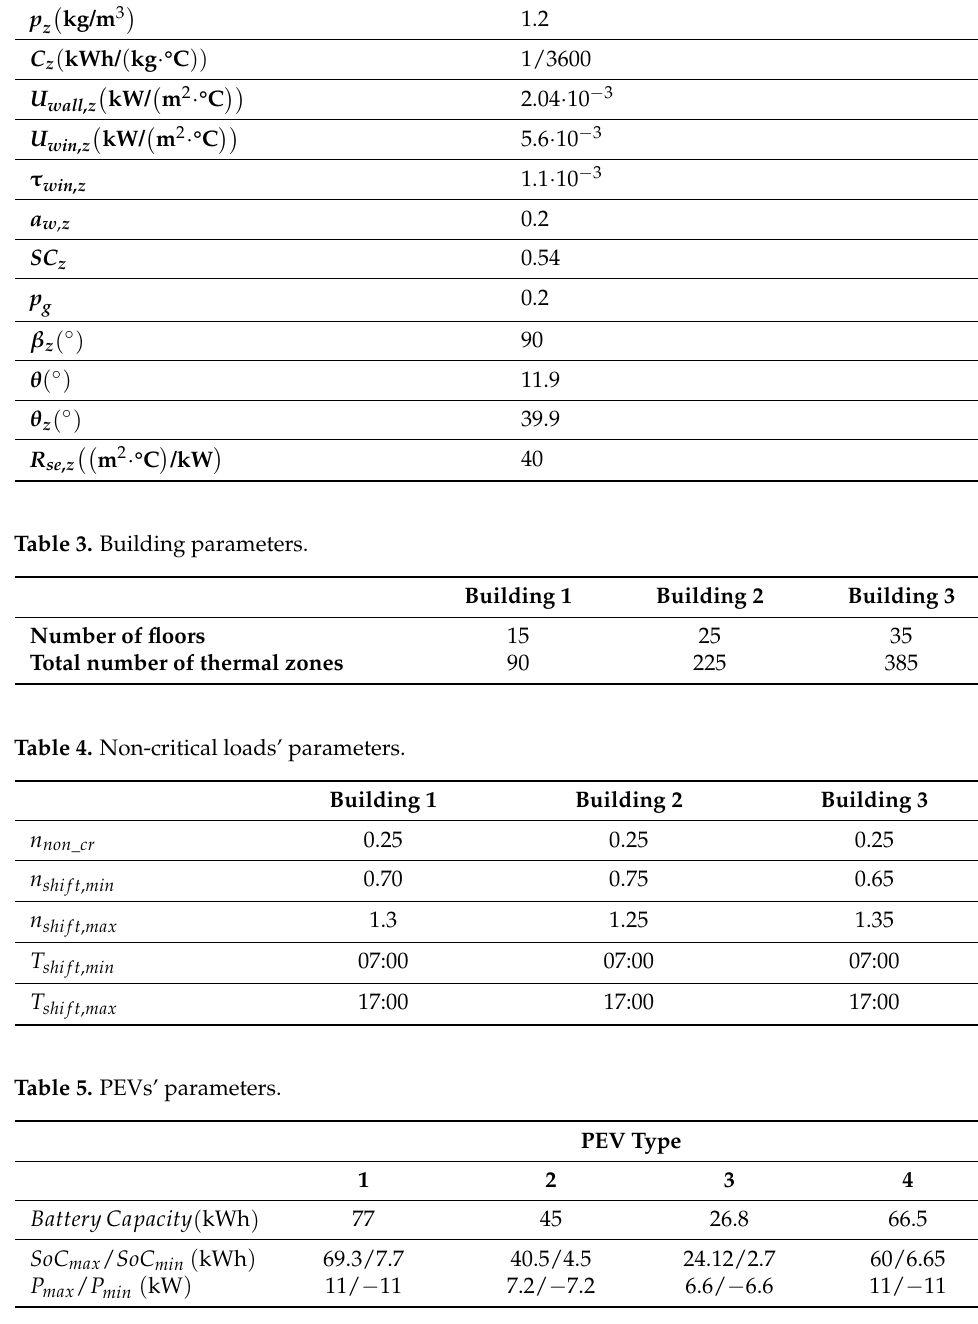
Table 2. Thermal zones’ parameters.